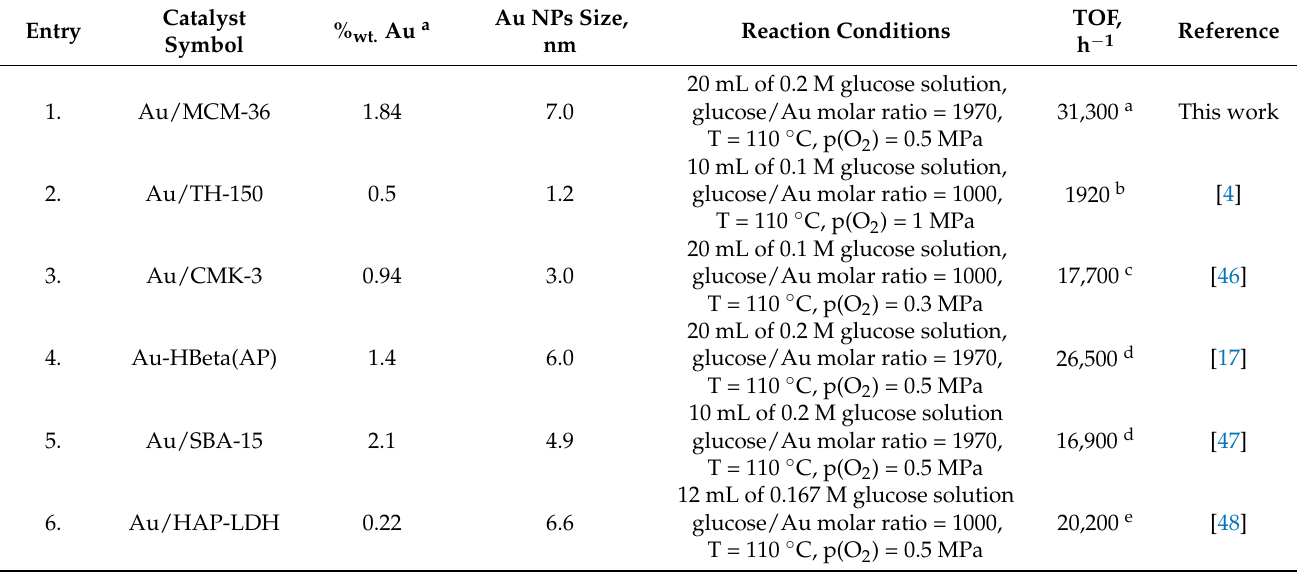
Table 4. Comparison of TOF values of different gold catalysts in base-free glucose oxidation with molecular oxygen as